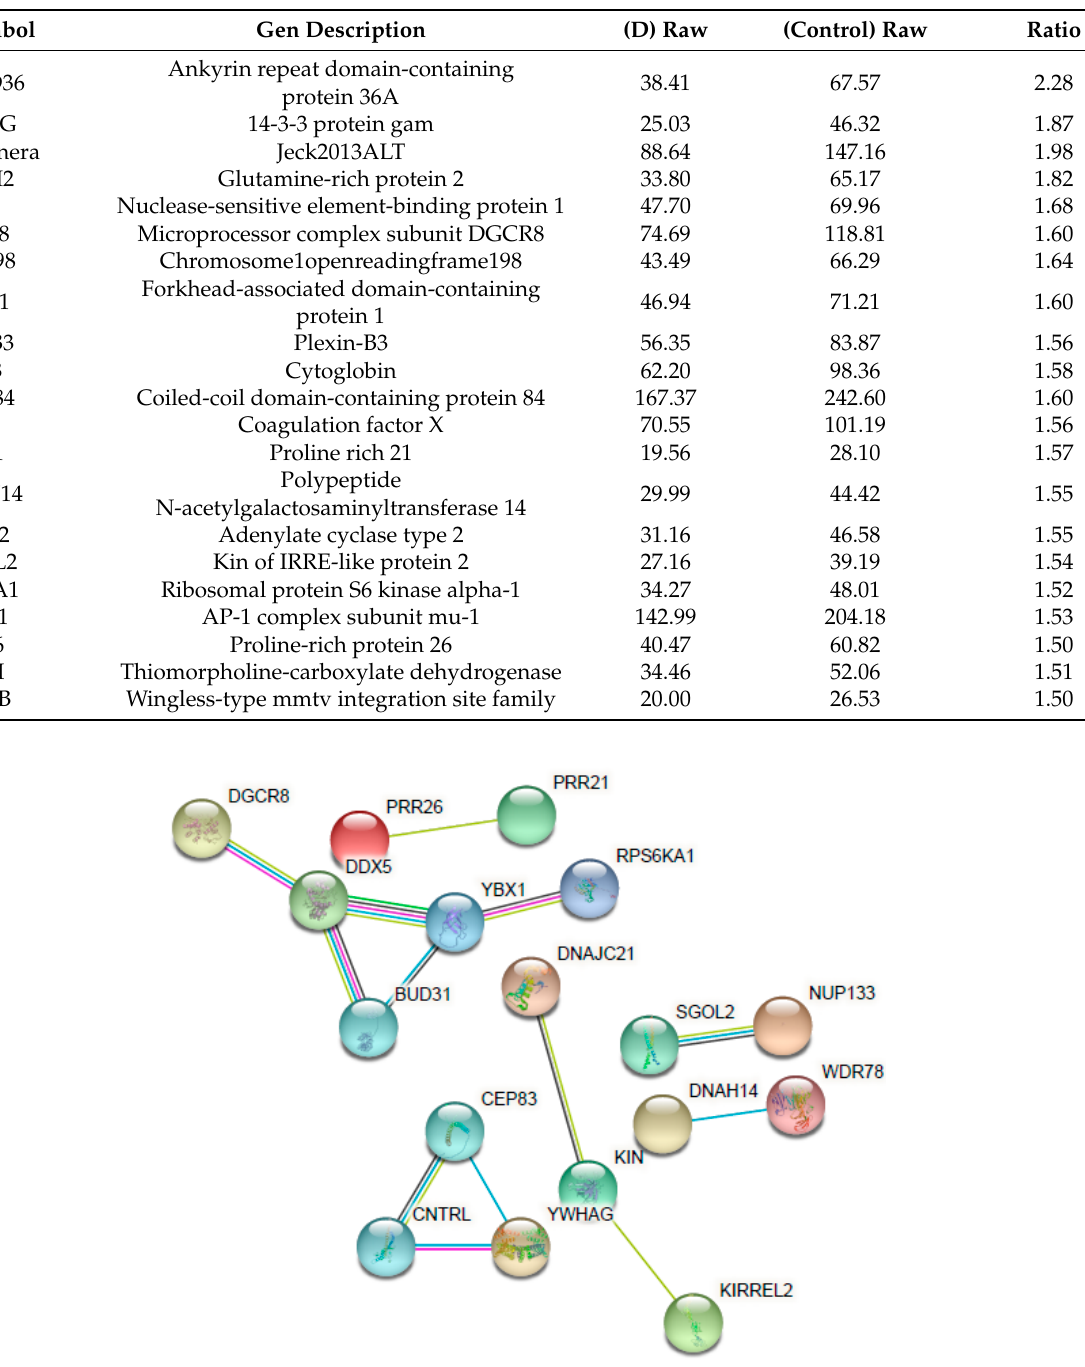
Table 4. Downregulated genes. Target prediction was performed using Affymetrix software. A list of differentially expressed (more than 1.5-fold, t -test p -value < 0.05) putative targets was obtained. The ratio column corresponds to the fold change in expression for each gene relative to the control, calculated from the normalized values.